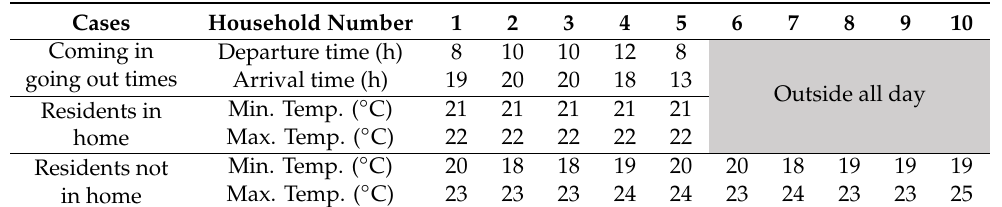
Table 4. Temperature control of each household in